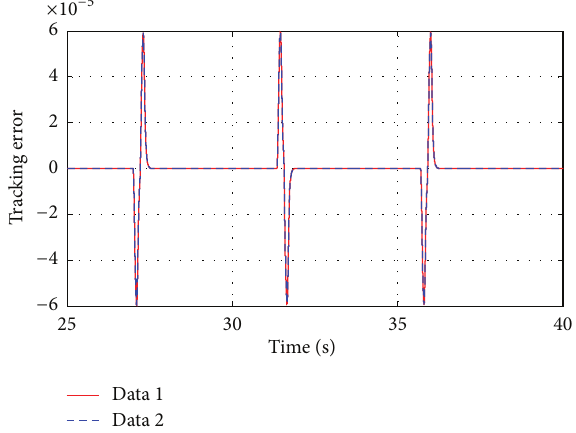
Figure 8: Point to point motion trajectory profile.